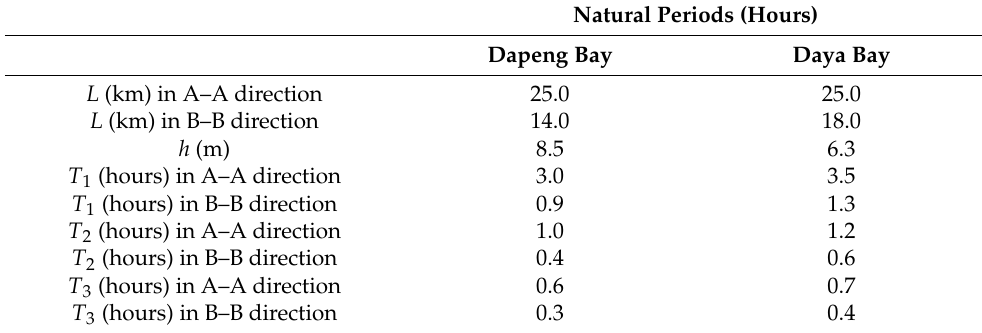
Table 1. Estimated natural periods of Dapeng and Daya Bays based on Equations (1) and (2). Natural Periods